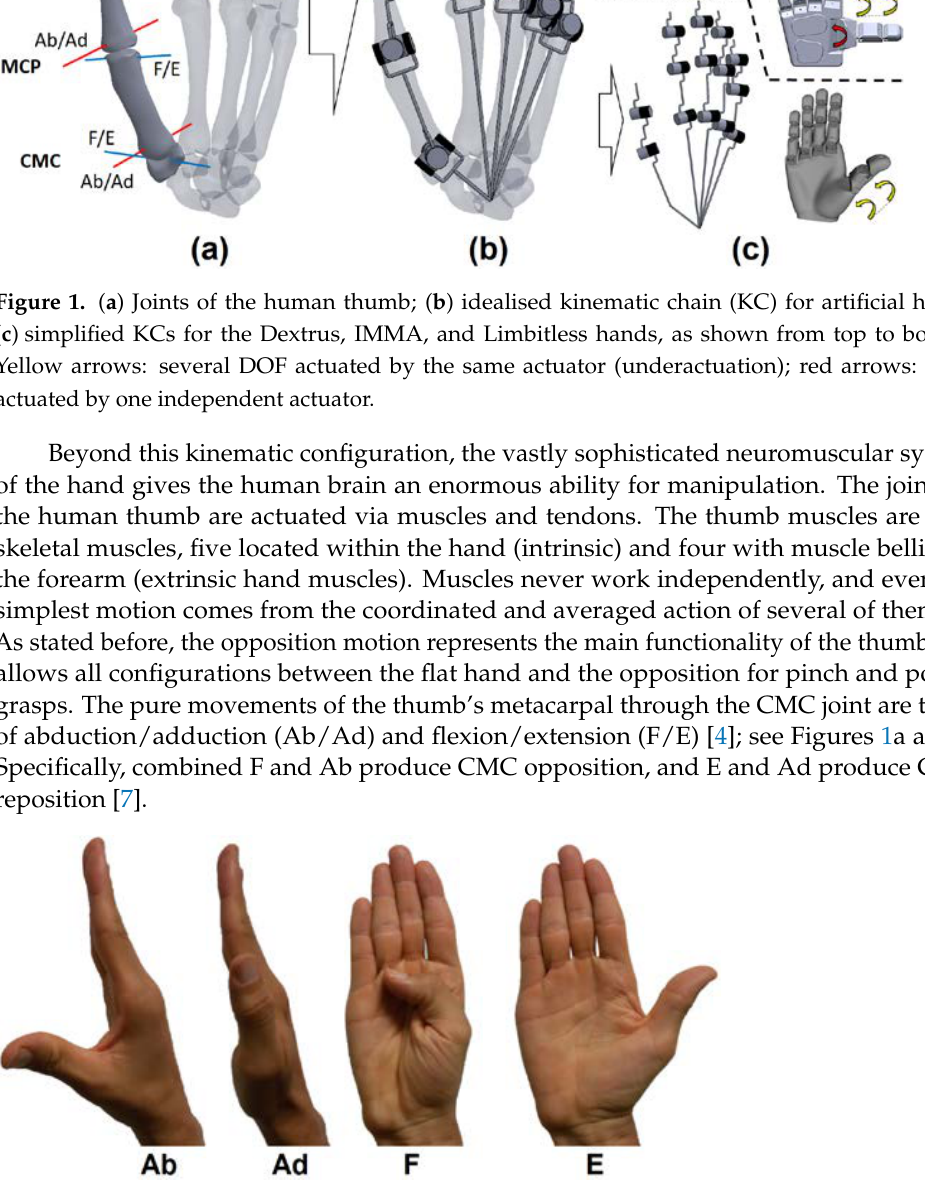
Figure 2. Abduction/Adduction (Ab/Ad) and Flexion/Extension (F/E) of the thumb.